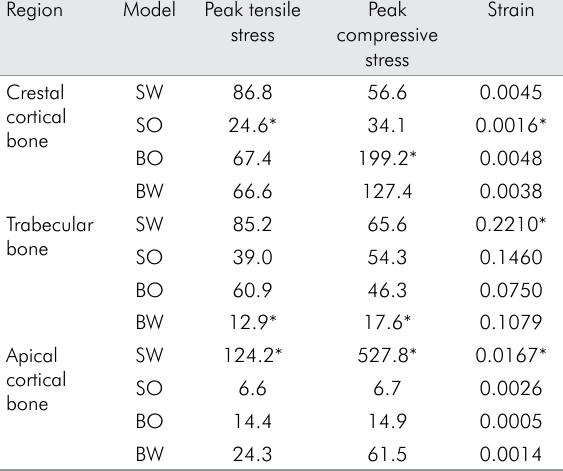
Table 3. Peak tensile and compressive stresses (MPa) and max- imum strain (µm) in the crestal cortical, trabecular, and apical cortical bone measured under eccentric loading